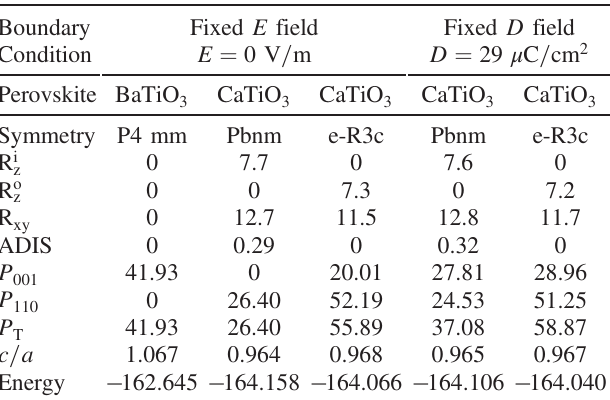
ð ∘ Þ , R o ð ∘ Þ , R ð ∘ Þ z z xy